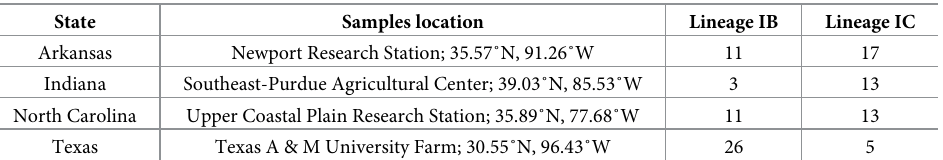
Table 2. Sampling locations and numbers for lineages IB and